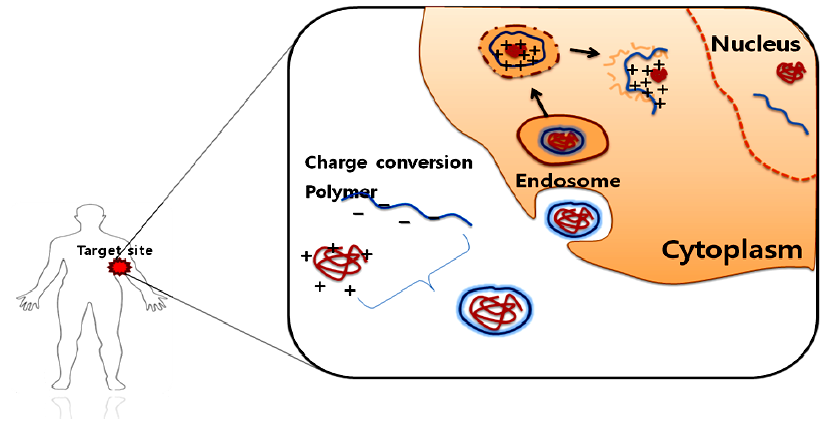
Figure 3 . Schematic representation of the actions of the charge-converting nanocomplex at endosomal